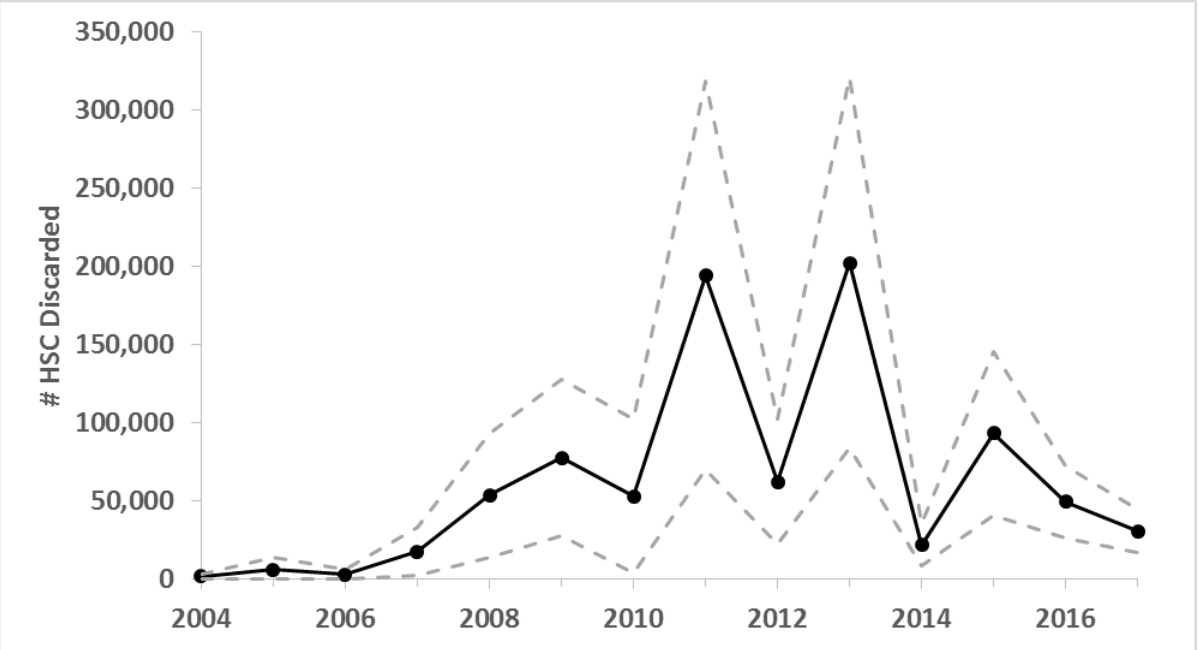
Figure 17. Estimated number of horseshoe crabs discarded from trawls in the Delaware Bay region, 2004-2017, with 95% confidence